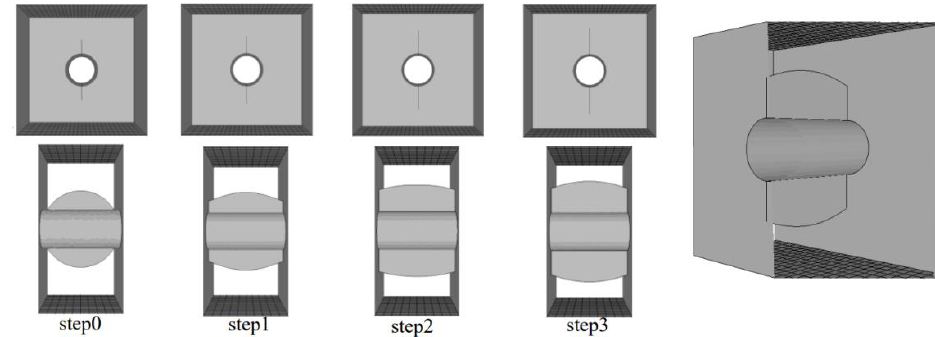
Figure 17. Main crack propagation process.